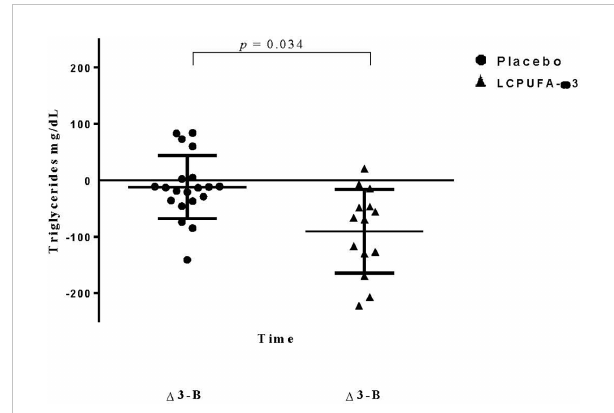
FIGURE 2 Changes in triglyceride levels. Data are expressed as mean ± standard deviation (SD). Data represent the triglyceride differences during the three months and basal time of treatment. Dependent- sample t-test was